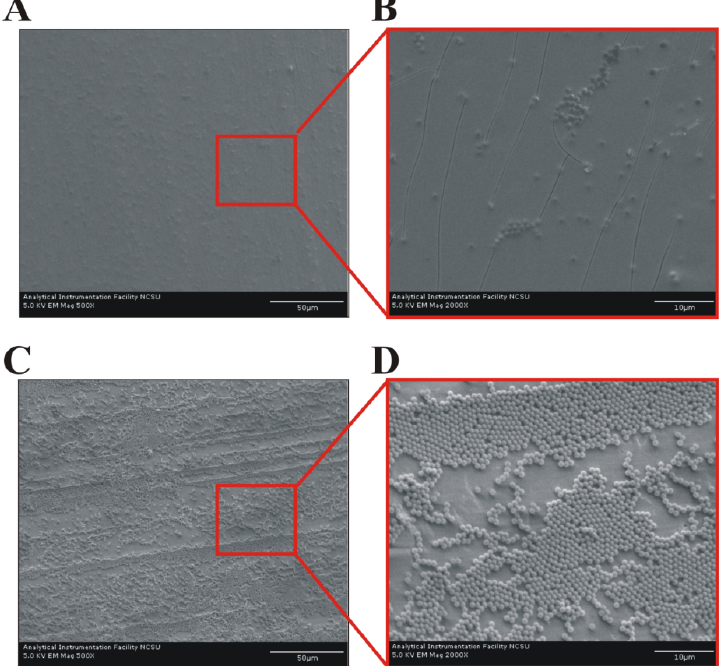
Figure 4. Microstructure of coatings deposited on aluminum foil. ( A , B ) 80% (v/v) composite OptiPrep TM + 1.0 µm microspheres and ( C , D ) pure 1.0 µm microspheres. Scale bars are 50 µm in ( A , C ), and 10 µm in ( B , D ). The ridges in ( C ) are an artifact that